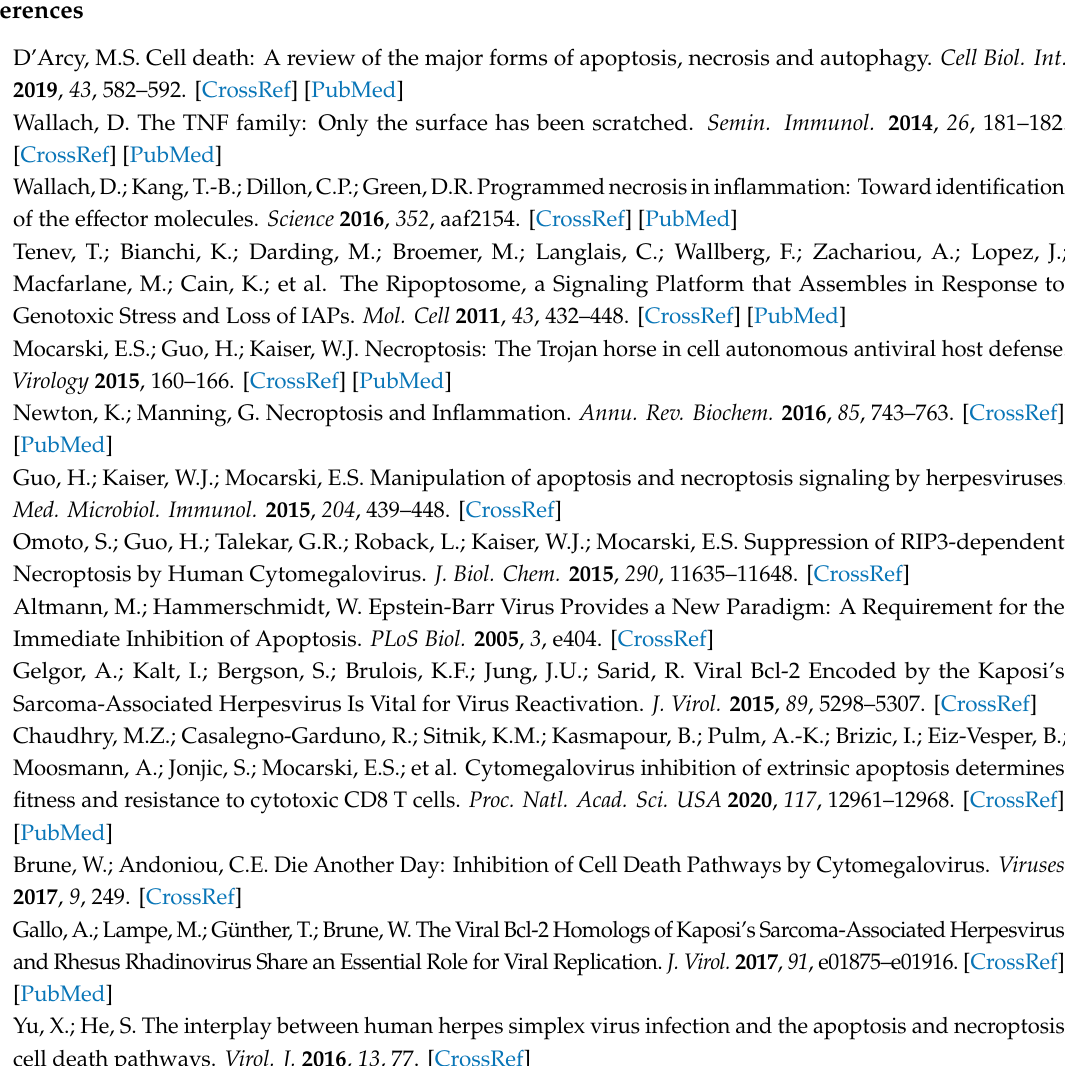
Figure S1: Role of CASP8 and type I IFN signaling during MCMV replication in vivo. Figure S2: TNF-induced apoptosis in ∆ M36-infected endothelial